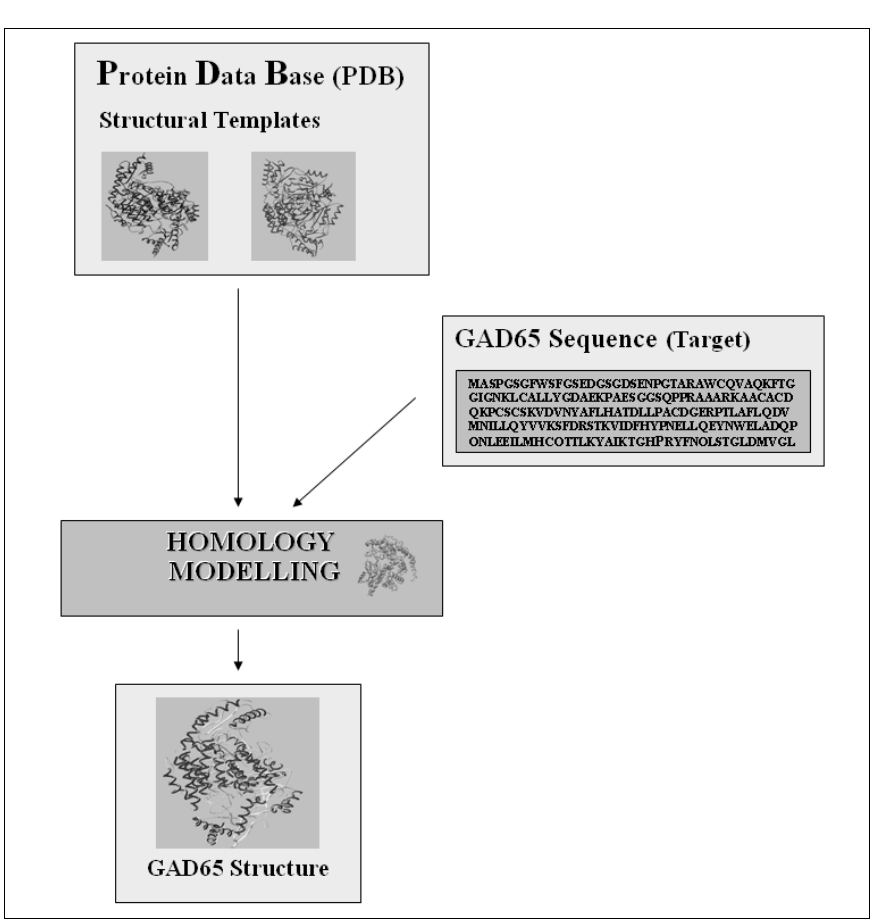
Figure 2: For a sequence, the structure can be predicted by homology modelling. In homology modelling a pro- tein sequence with an unknown structure (the target) is aligned with one or more protein sequences with known structures (the templates). Homology modelling relies on the rules of spacing between atoms, bond lengths, bond angles etc., from observed values in known protein structures. By considering this structural information from the template structures, the new structure can be